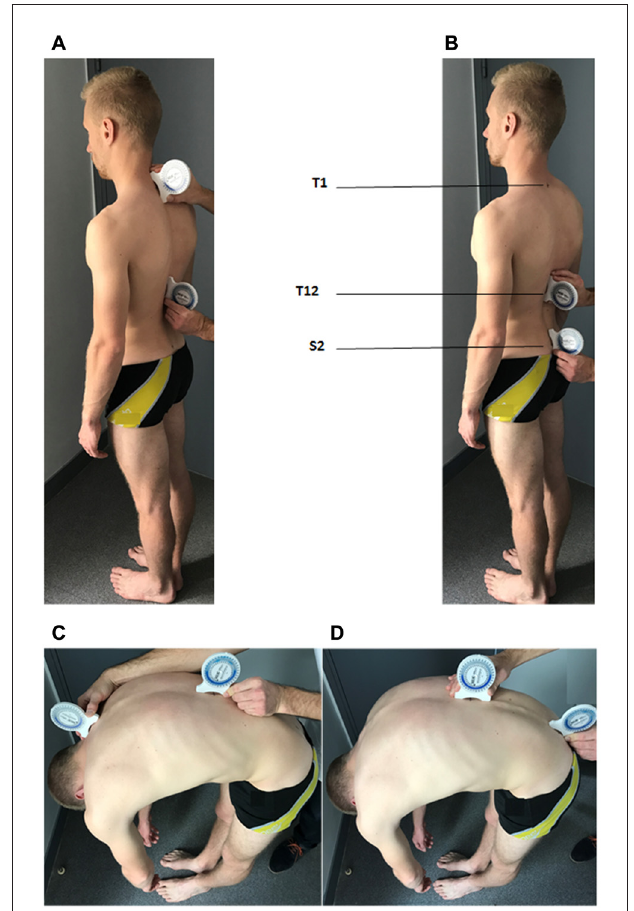
FIGURE 3 | Positioning of the two inclinometers for the evaluation of the spine range of motion. (A) Inclinometers are positioned over the spinous process of the first and last thoracic vertebrae (T1 and T12, respectively) and are calibrated in this position for the evaluation of the maximal thoracic flexion (C) . (B) Inclinometers are positioned over T12 and the spinous process of the second sacral vertebrae (S2) and are calibrated in this position for the evaluation of the maximal lumbar flexion (D) . The written informed consent was obtained from the participants depicted in the